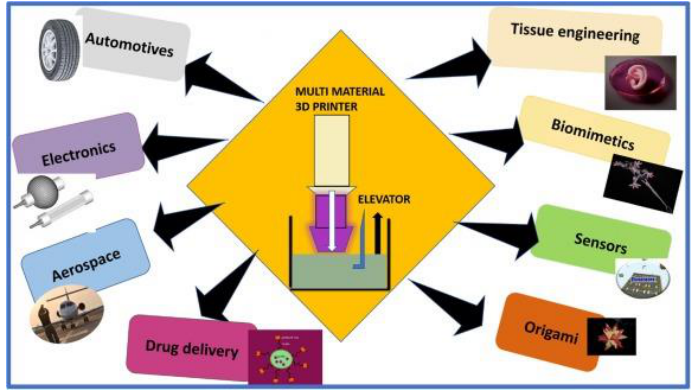
Figure 1. Applications for SMPs/SMPCs [2]. Copyright © 2022 Elsevier.